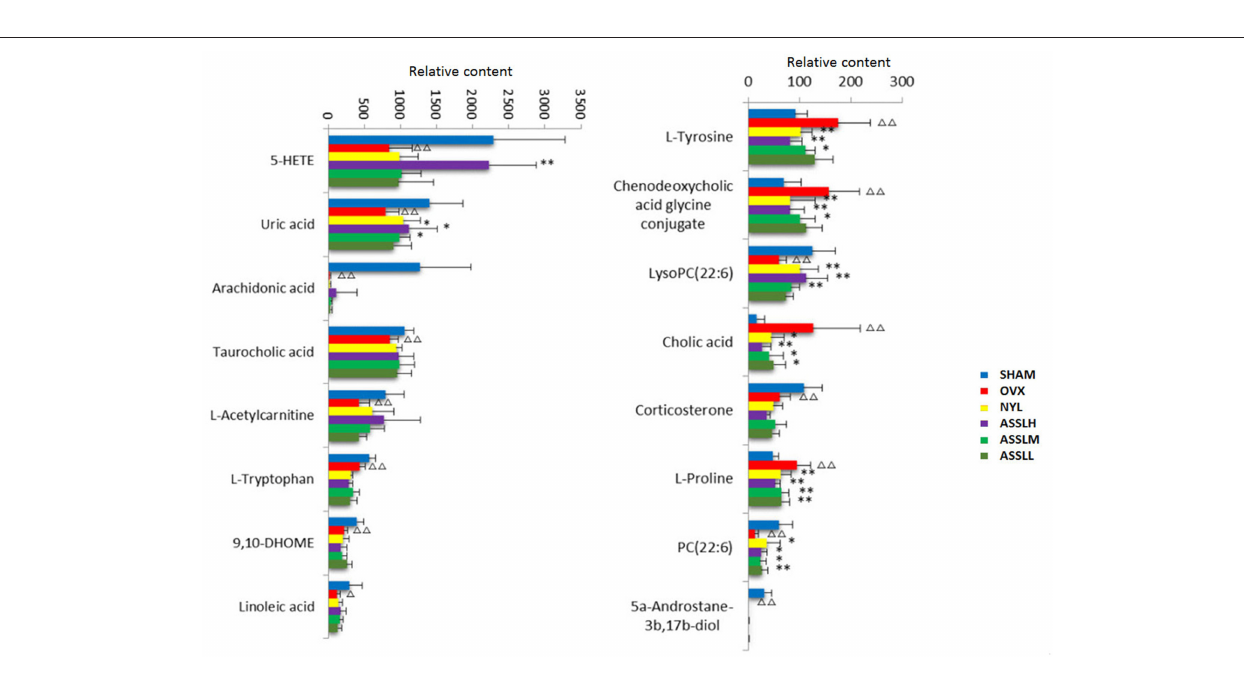
FIGURE 12 | Changes of potential biomarkers in total lignans on the ovariectomized osteoporosis rat model. , Sham operation group; , OVX Model group; , NYL; , ASSLH; , ASSLM; , ASSLL (Compare with sham group, 1 P < 0.05, 11 P < 0.01; compare with OVX Model group, * P < 0.05, ** P <